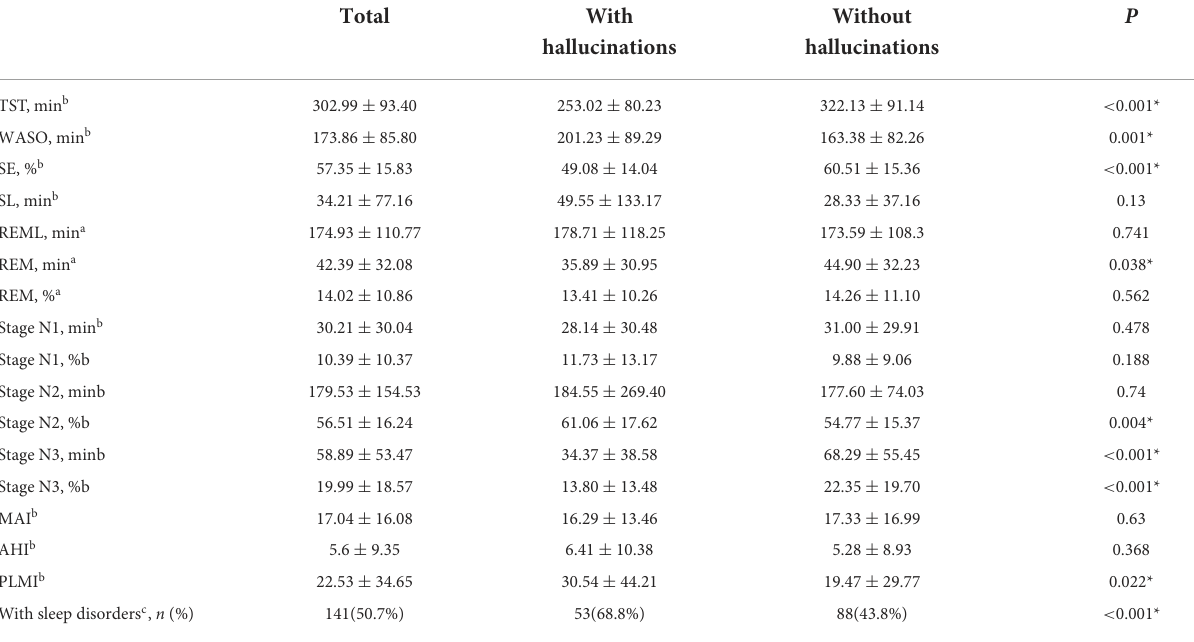
TABLE 4 Polysomnographic variables according to the presence/absence of hallucinations in Parkinson’s disease patients.